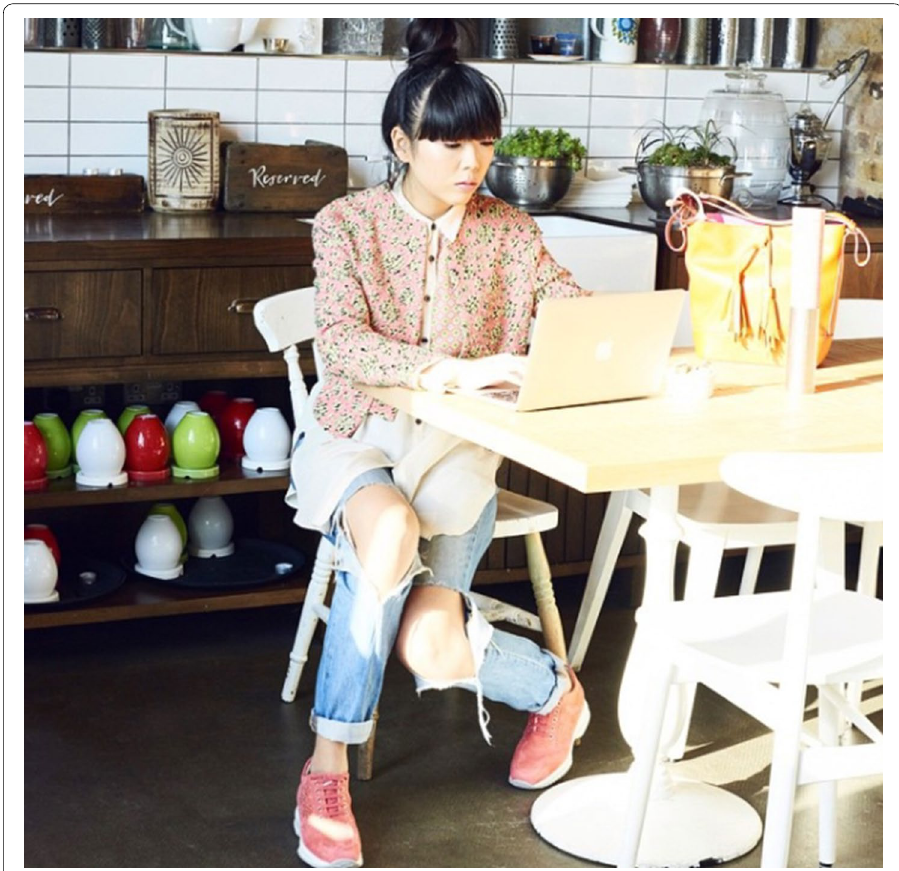
Fig. 5 Tapping away at grain store. https ://www.insta gram.com/p/1A5yY kKajC /. Accessed 14 September